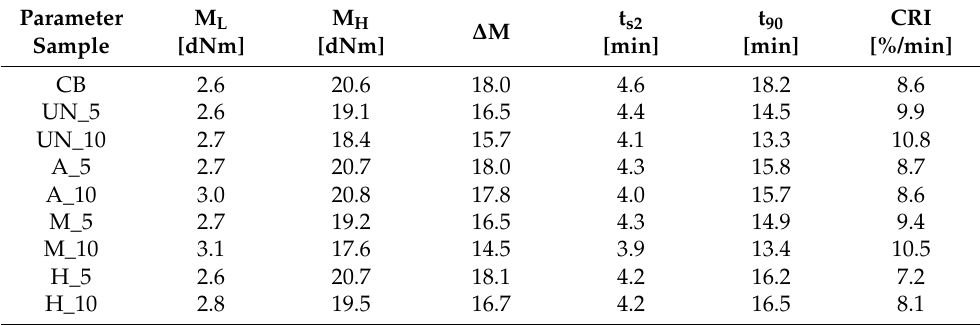
Table 5. Parameters of vulcanization of the GTR-containing rubber mixes